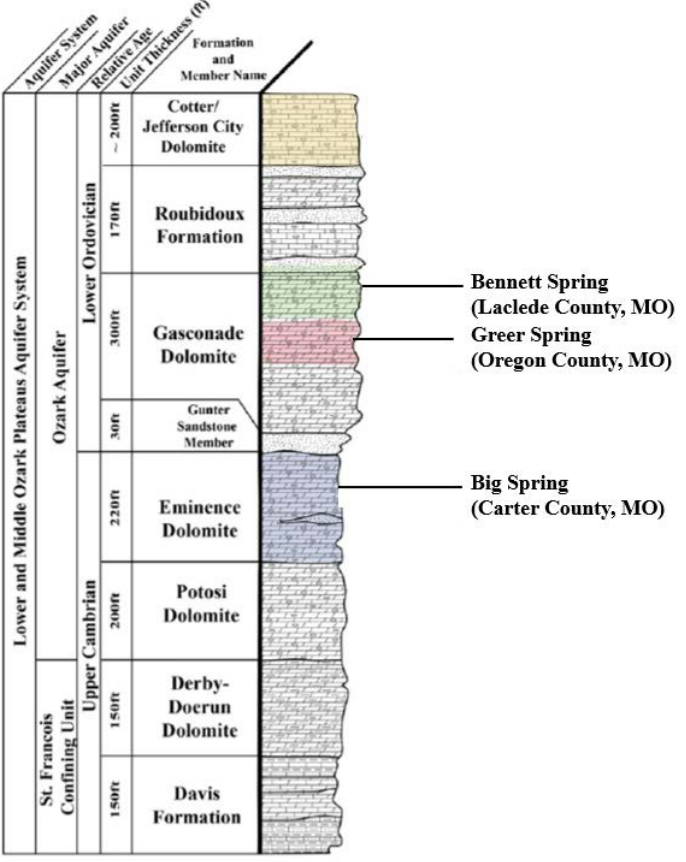
Figure 2. Hydrostratigraphic column showing Ozark aquifer and underlying confining unit; 1.00 ft = 0.305 m. Adapted with permission from Ref. [39]. Copyright 2020, Jordan Vega.